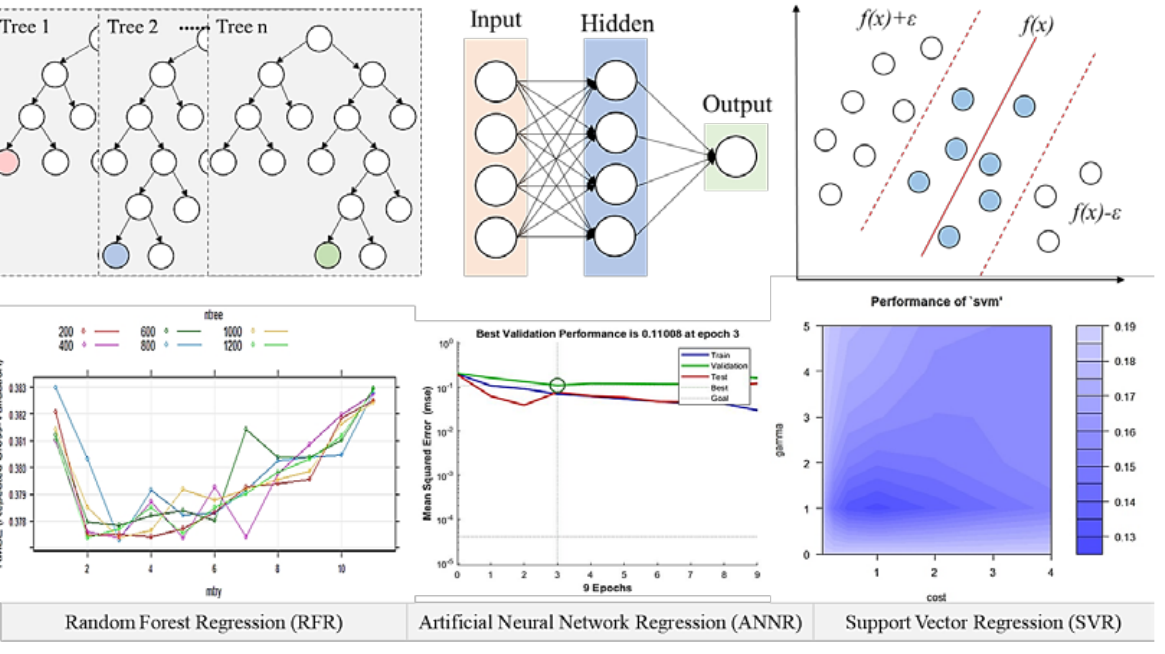
Figure 4. The settings and selecting values of tuning parameters using RFR ( left ), ANNR ( middle ) and SVR ( right ) models.